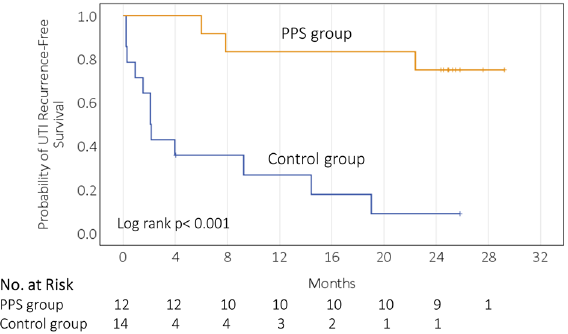
Figure 2. Kaplan–Meier survival curves for UTI recurrence-free survival in 26 patients.